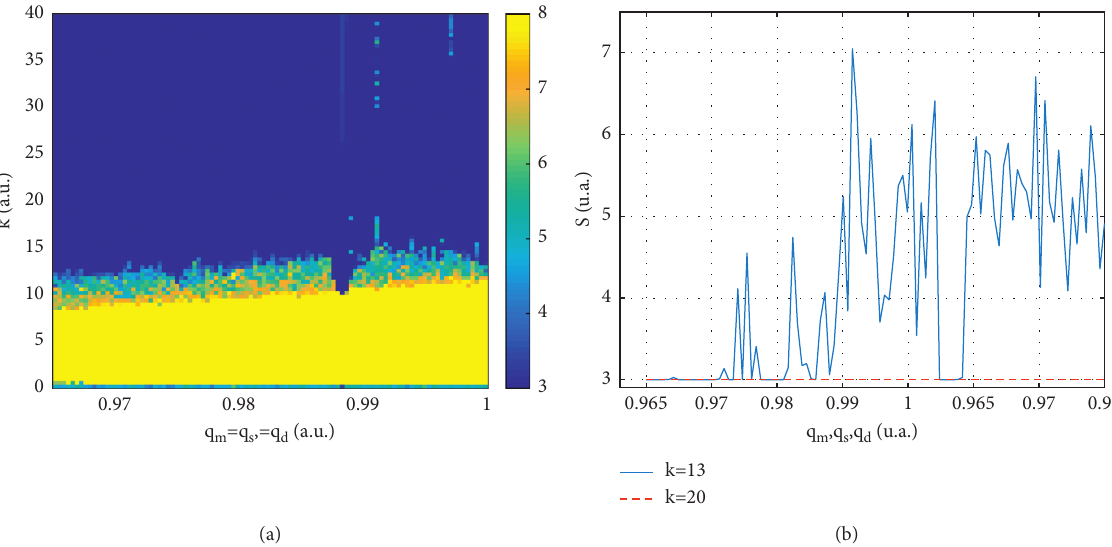
Figure 8: Numerical result equations (25)–(27). (a) Limit behavior of the system as a function of coupling strength k and integration order q . (b) Synchronization index equation (14) as a function of integration order, for a fixed k � 13 and k � 20. A value of S � 3 indicates complete